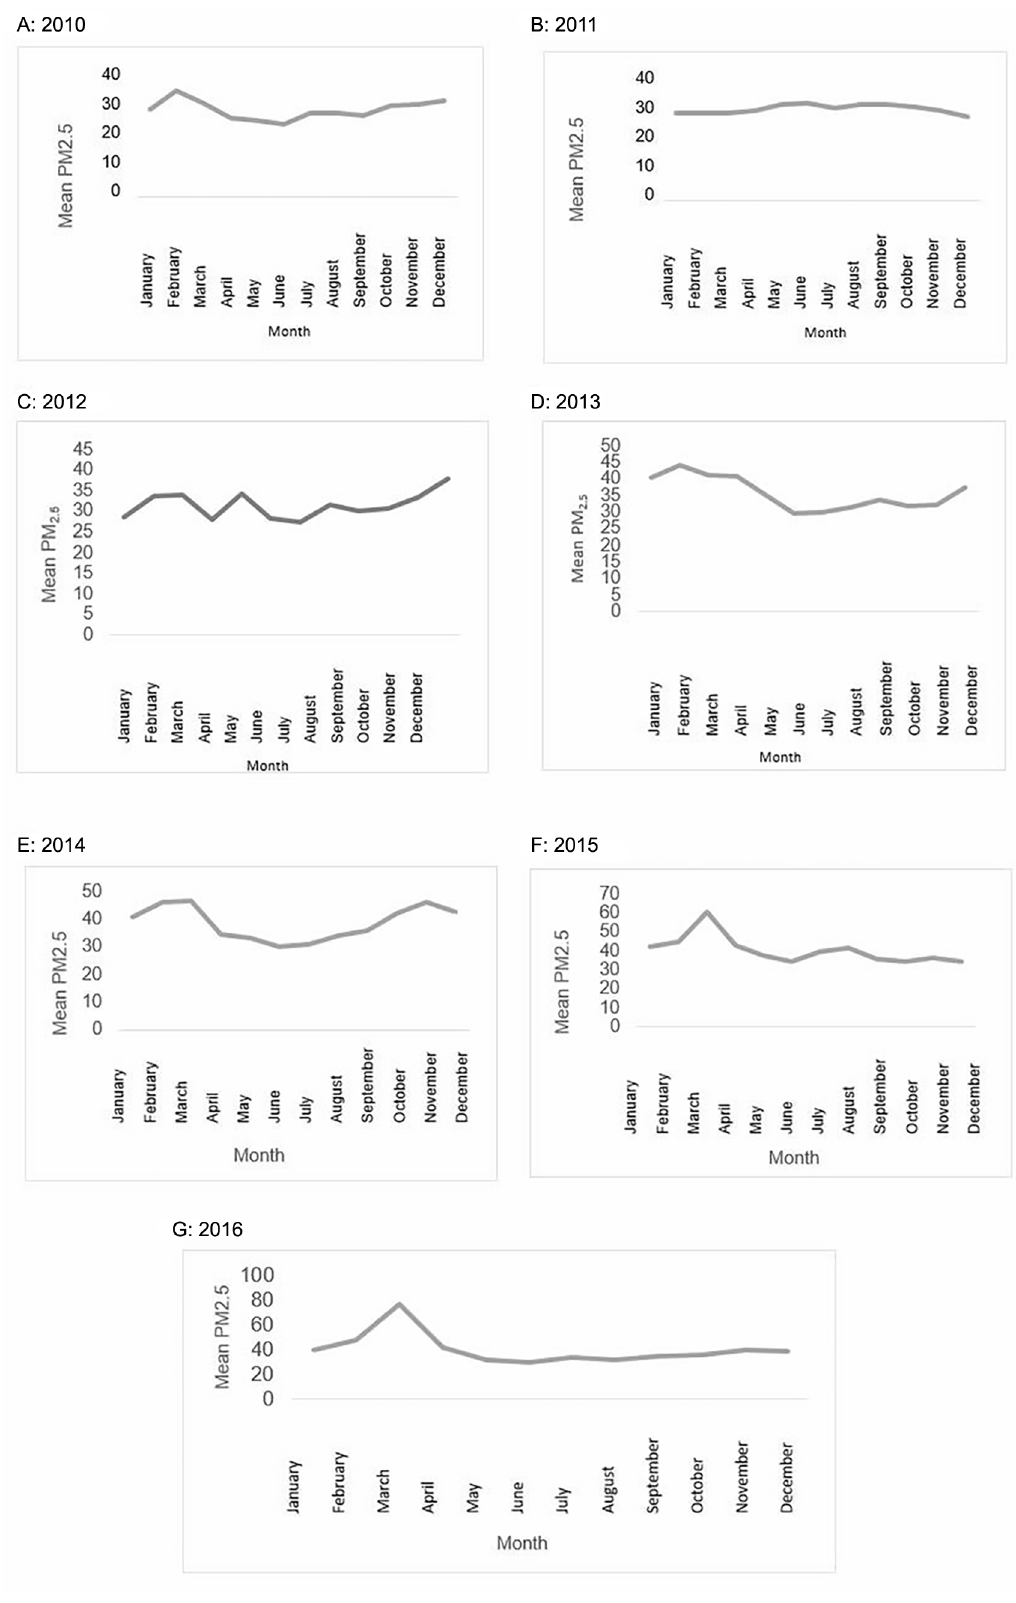
Figure 1. Monthly average of PM 2.5 , 2010 –